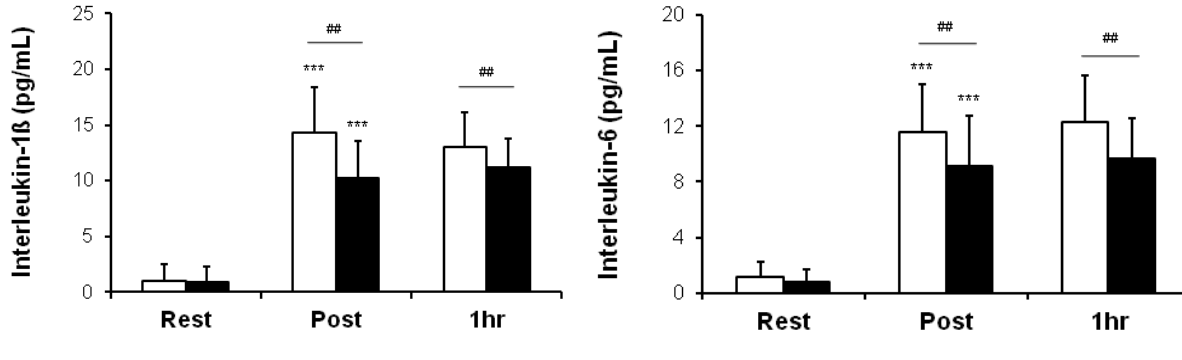
Figure 1. Serum concentrations of interleukin (IL)-1 β and IL-6 over time in two groups. Rest: before heating; Post: immediately after heating; 1 h: 1 h after heating. White columns indicate placebo intake, and black columns, oligonol intake. Values are presented as the mean ± standard deviation. *** p < 0.001 indicates a significant difference in comparison to Rest within the same group, and ## p < 0.01 indicates a significant difference between two